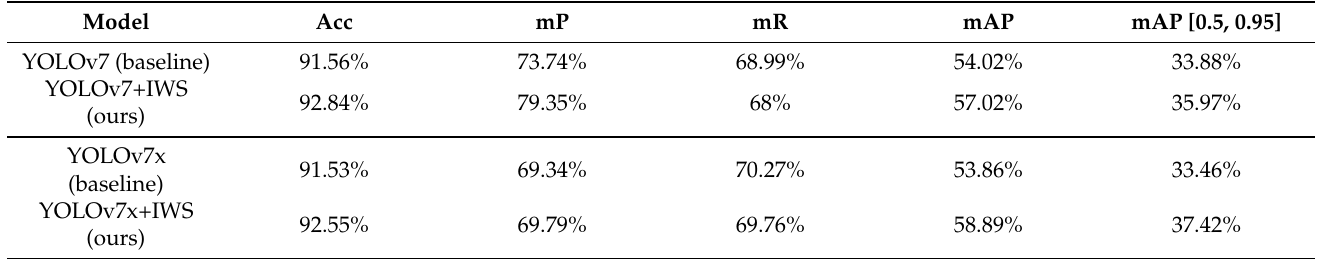
Table A1. Experimental results of IGBT_DF dataset based on YOLOv7 and YOLOv7x.